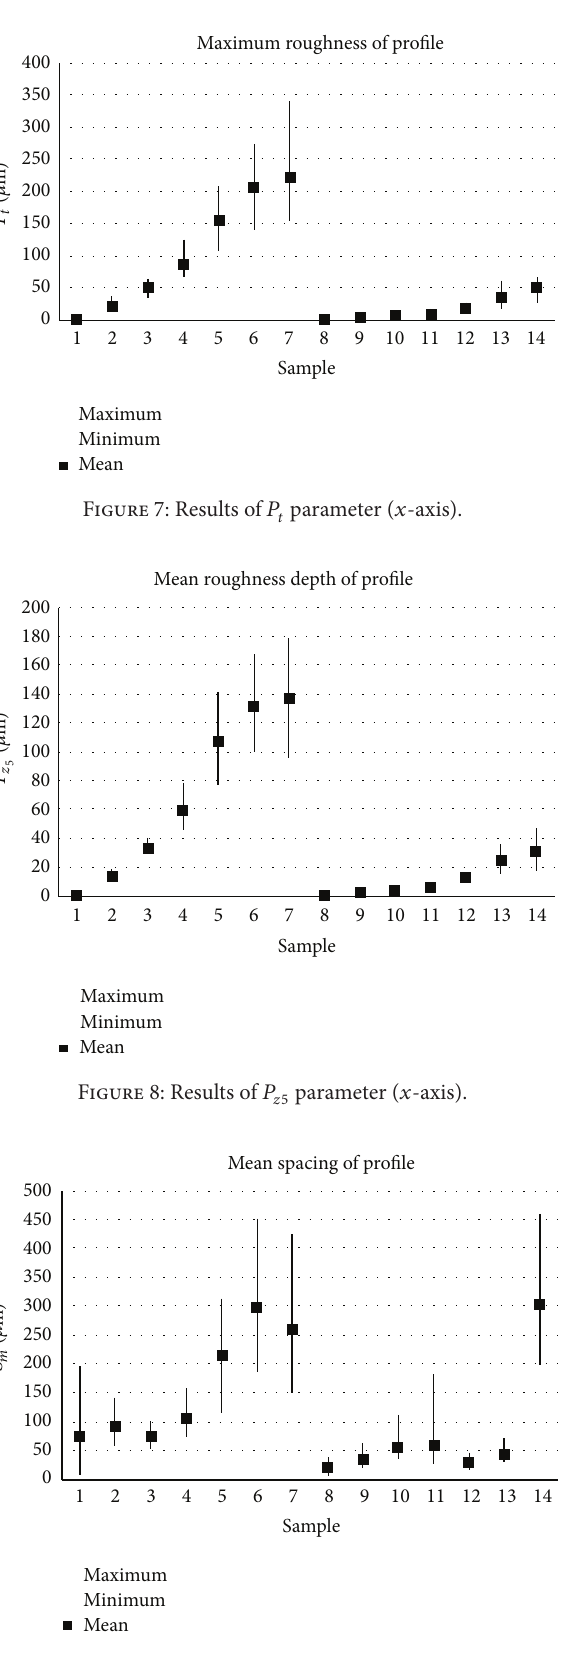
Figure 9: Results of 𝑆 𝑚 parameter ( 𝑥 -axis).